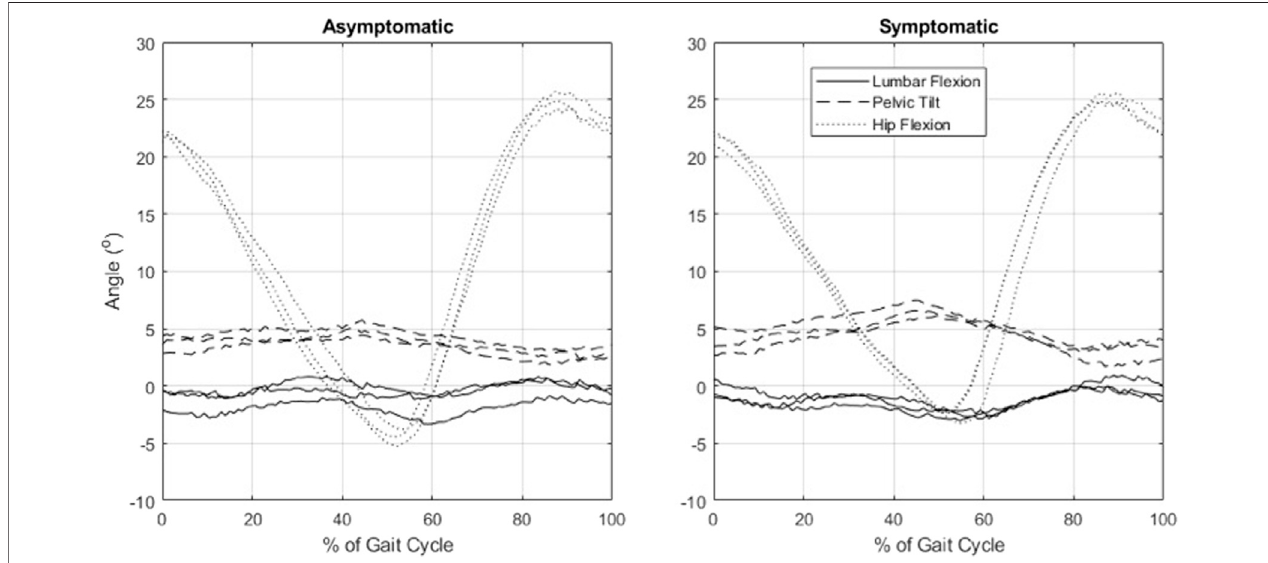
FIGURE 2 | Example data from a participant with symptomatic lumbar spinal stenosis showing sagittal plane pelvic, spinal, and hip kinematics during a single gait cycle in three independent trials, as evaluated by optical motion capture and inverse kinematics analysis.